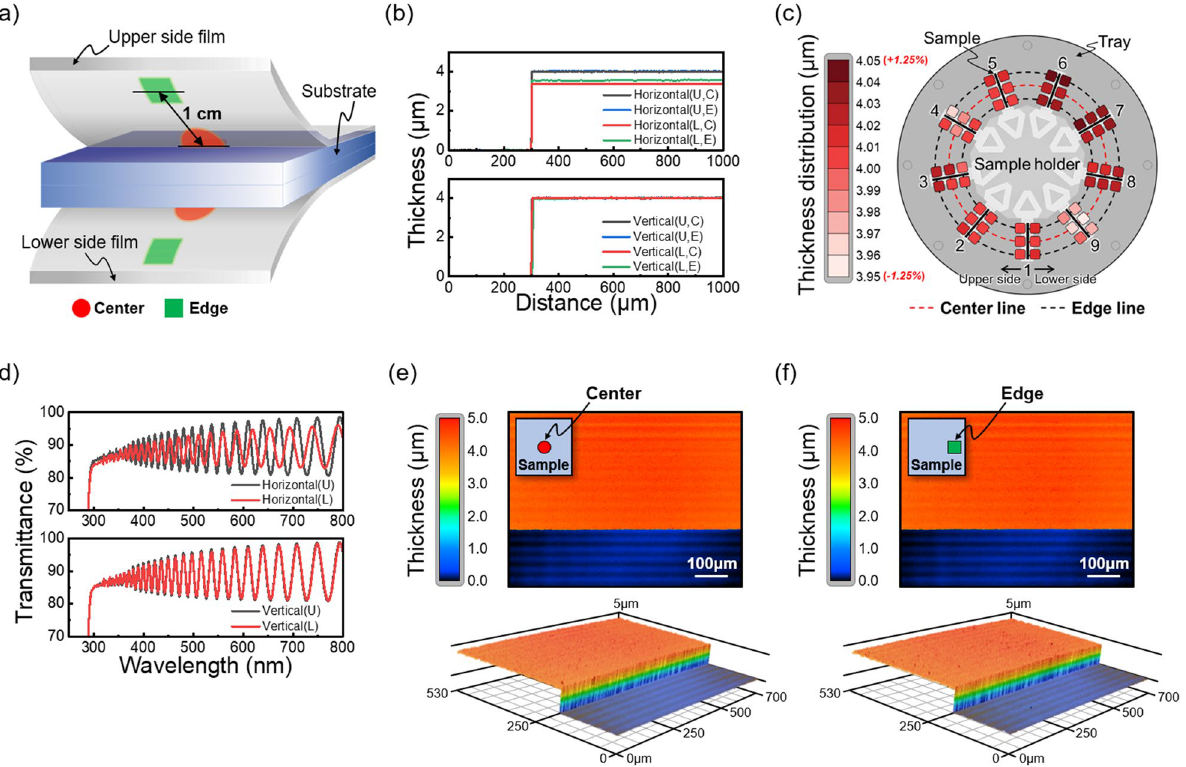
Figure 2. ( a ) A schematic diagram of the two-sided deposition sample of parylene C film. ( b ) Film thickness measurement results in all cases, and ( c ) thickness distribution of vertical deposition samples. ( d ) Transmittance measurement results in all cases, and surface morphology measurement results for ( e ) center and ( f ) edge area of vertical deposition surface of the wafer. Figure 1d is a picture of the sample holder placed on the sample tray, and a video showing the actual rotation can be seen in Supplementary Video S1. Prior to the measurement, we specified the measurement location on the film formed on the sample. A schematic diagram divided by a red circle marked at the center of the sample and a green square at the edge 1 cm away from the center is shown in Fig. 2a. We sought to form a parylene C film with a thickness of 4 μm, and after placing the samples in the equipment (product of Young Hi-Tech, Rep. of Korea) in the horizontal and vertical directions, respectively, deposition was carried out. O 2 plasma etching was then performed in advance to clearly distinguish the substrate and film boundary, and the recipe and process are summarized in Supple- mentary Fig. S2. The parylene C film thickness was measured using a stylus profilometer (P-15 of KLA-Tencor), and the results are shown in Fig. 2b. U, L, C, and E are abbreviations for Upper side, Lower side, Center, and Edge, respectively. In the case of horizontal deposition, the thickness of the lower side film is thinner than that of upper side film, which is ascribed to the difference in the growth rate according to the reduced flow rate, as mentioned above. To make matters worse, the thickness at the central part of the lower side film turns out to be thinner than the edge part, which can be regarded to come from the micro gap formed between the substrate and the tray 18 . In the case of vertical deposition, on the other hand, the thicknesses of both the upper side and lower side films converge to 4 μm, because a sufficient flow rate acts on both surfaces and the boundary layer thickness becomes sufficiently small, resulting in a surface reaction limited state. To assess the thickness uniformity of each of the samples used in the vertical deposition, we checked the thickness distribution at the center and the edge in the upper side and lower side films for a total of nine samples. As shown in Fig. 2c, we were able to confirm that parylene C films made with the vertical deposition exhibit a very uniform thickness distribution within an error range of 2.5% with respect to the target thickness of 4 μm. Transmittance spectra of the films measured using a UV–Vis spectrometer (LAMBDA 950 of PerkinElmer) also show that their sinusoidal modulation due to the interference effect coincides well between the upper-side and the lower-side films in the case of vertical deposition unlike the case of horizontal deposition. (Fig. 2d). Because the modulation period and the overall transmittance value are both dependent on the thickness of the films, the observed results are consistent with the measurement done with the surface profiler. Furthermore, the overall transmittance is higher than 80% in the entire visible light region, being consistent with the inherent high transparency of the parylene C film 25 . Finally, to verify the uniformity of the parylene C film once more, the surface morphology of the center and the edge of the vertically deposited sample was checked through a 3D laser scanning microscope (VK-X200 series of KEYENCE), and the results are shown in Fig. 2e, f. The result clearly